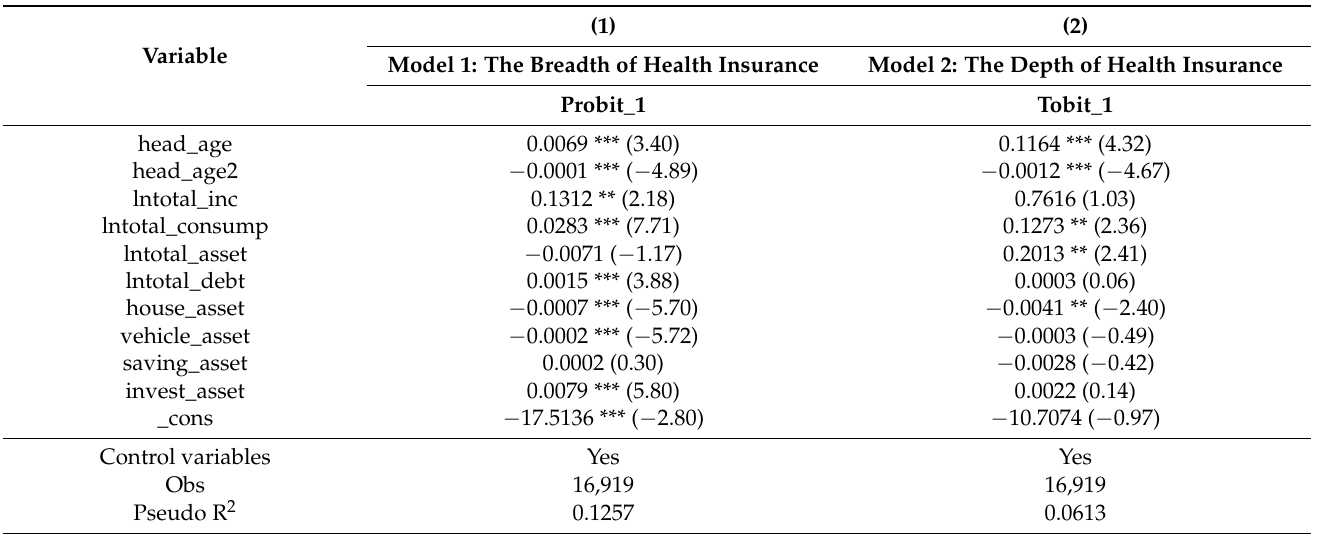
Table 6. Model estimation